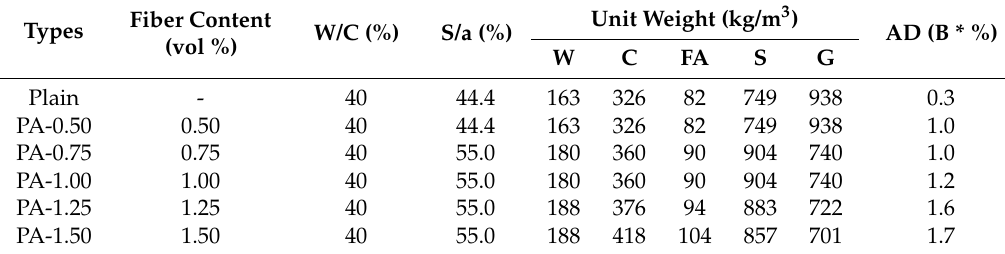
Table 1. Shotcrete mix design.